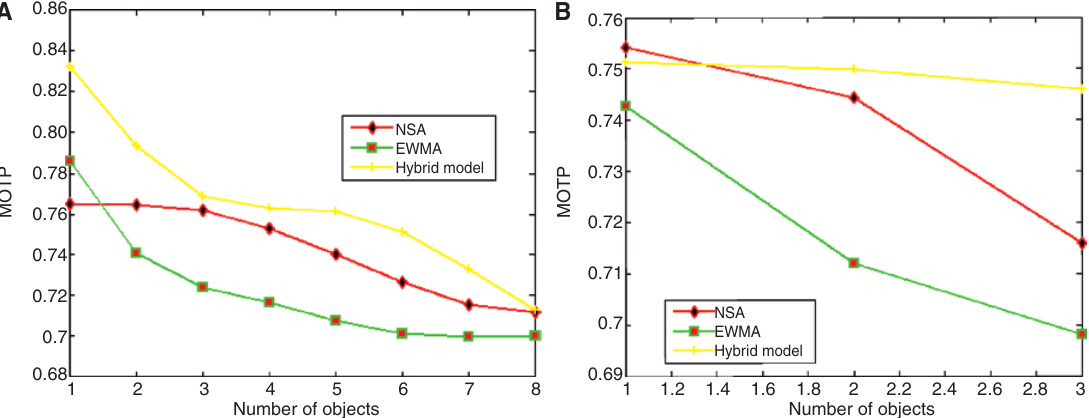
Figure 5: Performance Analysis of Object Tracking in (A) Video 1 and (B) Video